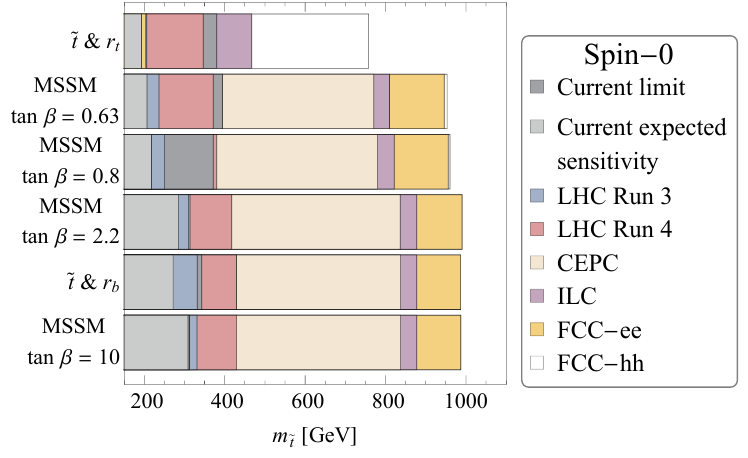
Figure 8 . Excluded parameter space and expected sensitivities at 2 (cid:27) C.L. on degenerate spin-0 (cid:17) m top partner mass, m ~ = m ~ ~ t , in the MSSM with various tan (cid:12) of current and future data. t 1 t 2